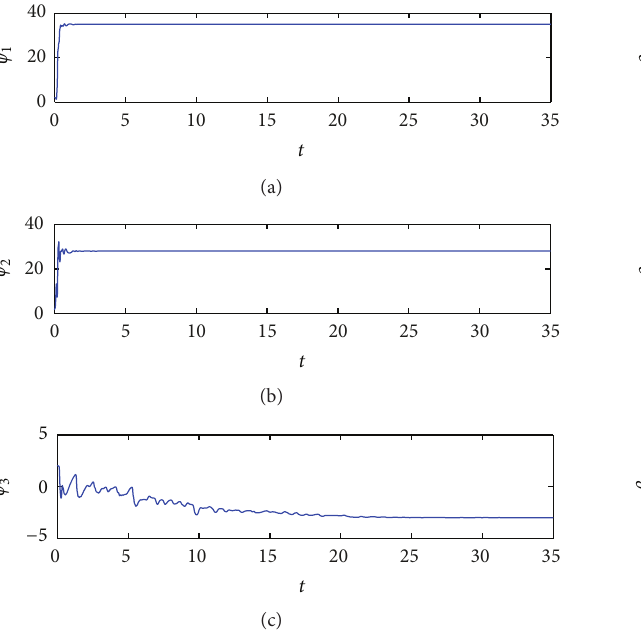
Figure 6: Time responses of the adaptive update laws ̂𝜓 in Example